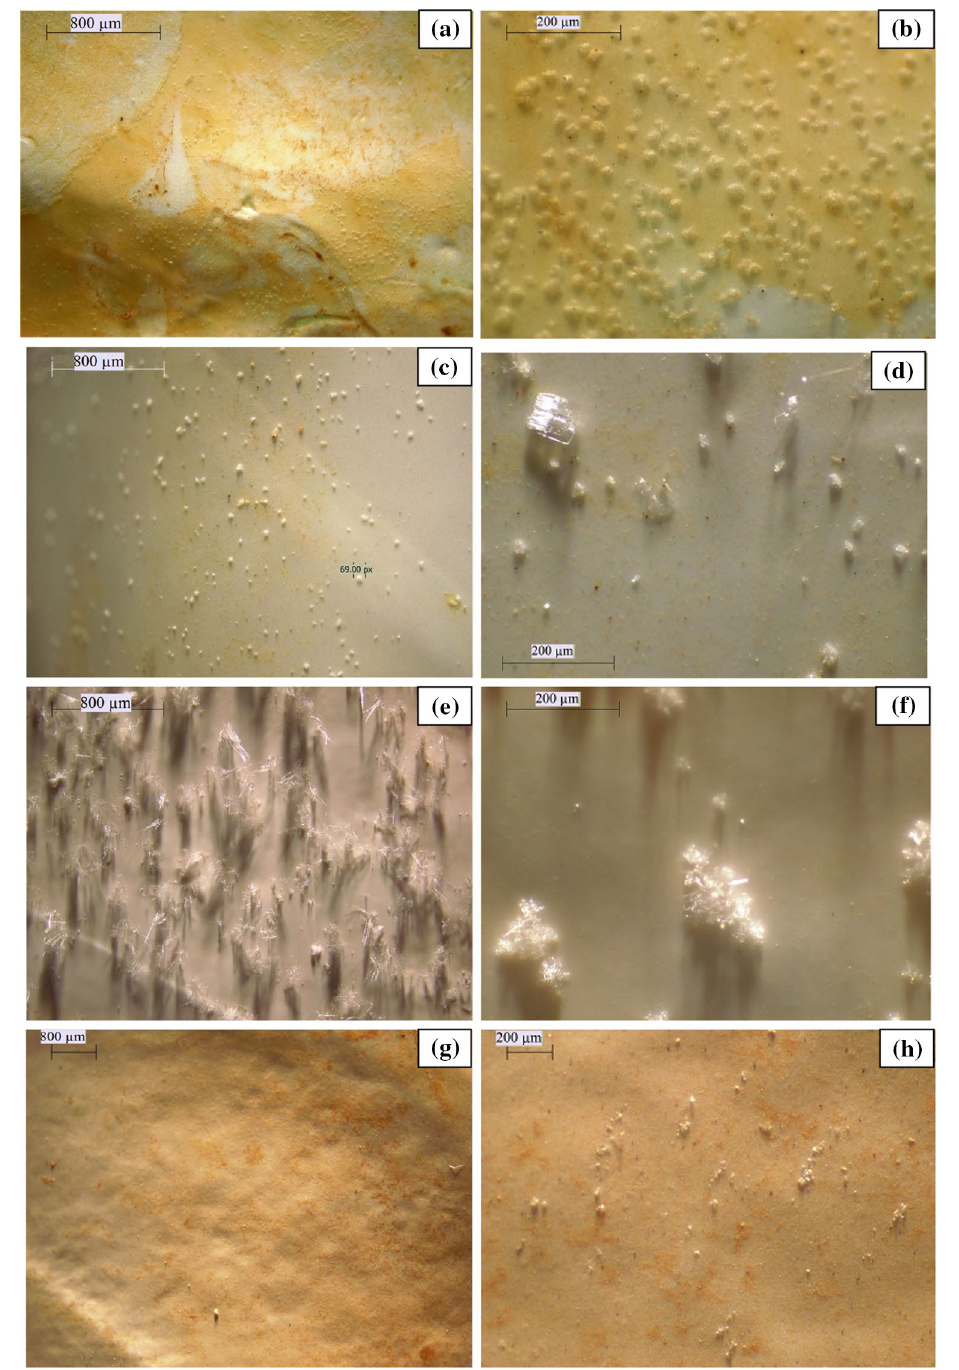
Fig. 16 Optical images of impurities stained with fouling layer formed on a , b Polyvinylidene difluoride or PVDF (FP100), c , d Polyethersul- phone (ES404), e , f Polyamide low-pressure film (AFC40) and g , h Polyamide high-pressure Film